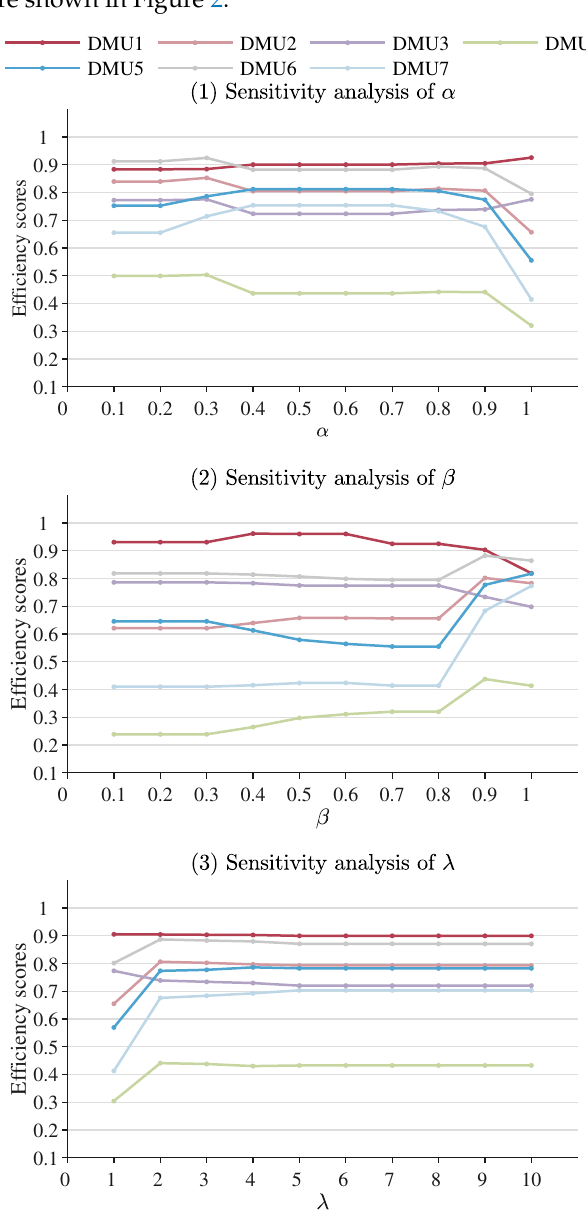
Figure 2. Sensitivity analysis of parameters in prospect theory ((1) α , (2) β , and (3) λ